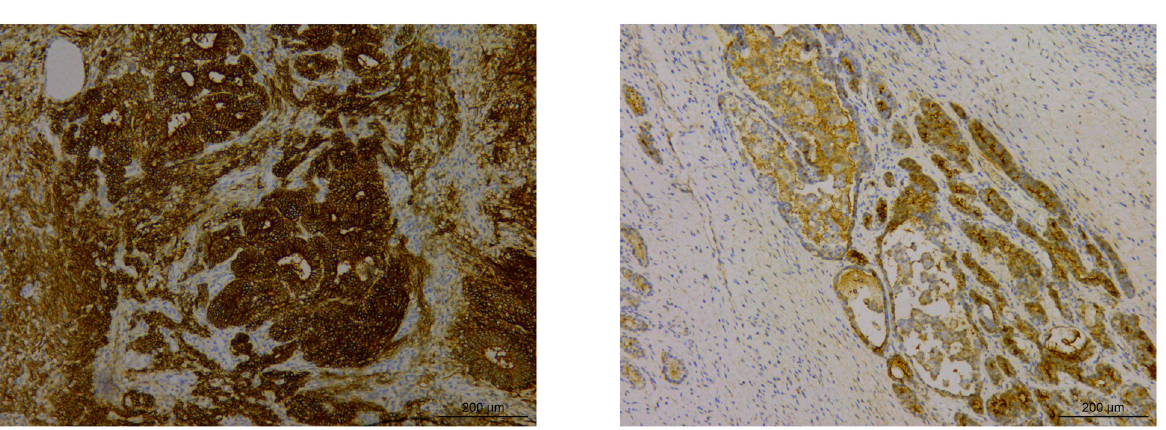
Fig. 4 Immunohistochemical staining visualized at 100